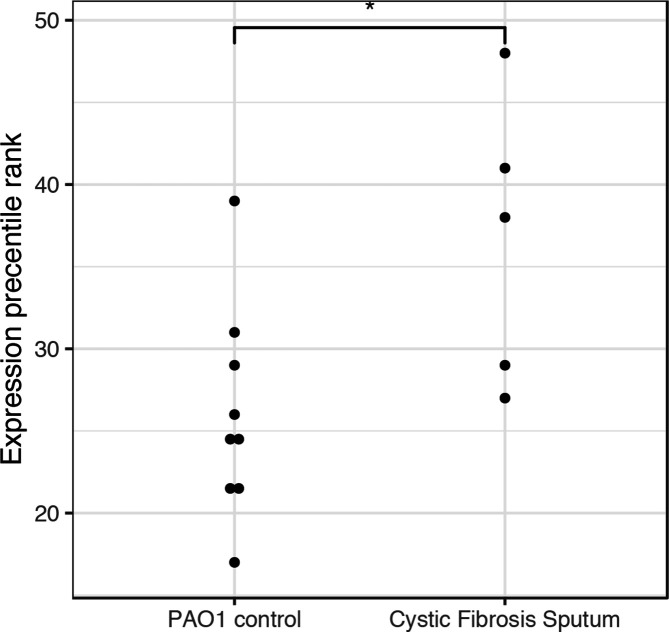
Dot plot of expression of PA4191 in GDS2869 (*P<0.05, two-sided Mann–Whitney U test).